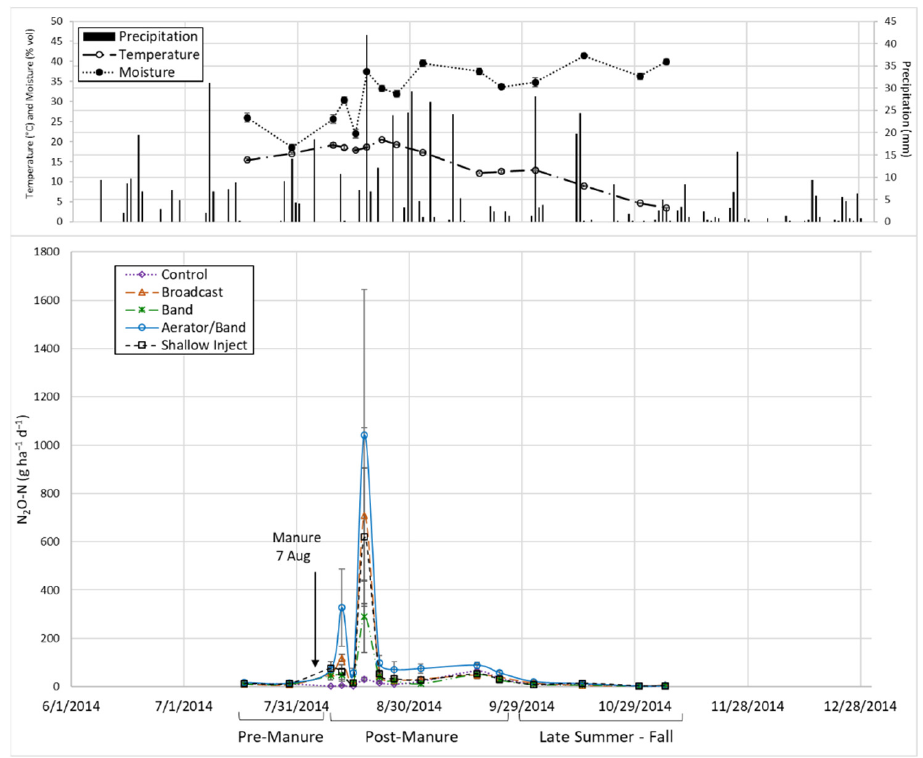
8 of 15 Figure 1. Average ammonia flux ( top ) and cumulative loss ( bottom ) for 2015 and 2016. Means without a common lower case letter differ at p < 0.10. 3.4. Manure Application Effects on Nitrous Oxide Fluxes Mean N 2 O fluxes were larger after manure application, consistent with previous experiments [18,20,26,33,50,51]. In general, larger N 2 O fluxes were associated with Inject and Aerator/Band treatments, whereas the no manure control had the lowest N 2 O fluxes (Figures 2–4). Smaller N 2 O fluxes occurred outside the manure application times and were associated with precipitation and higher soil water contents. Mean cumulative N 2 O-N